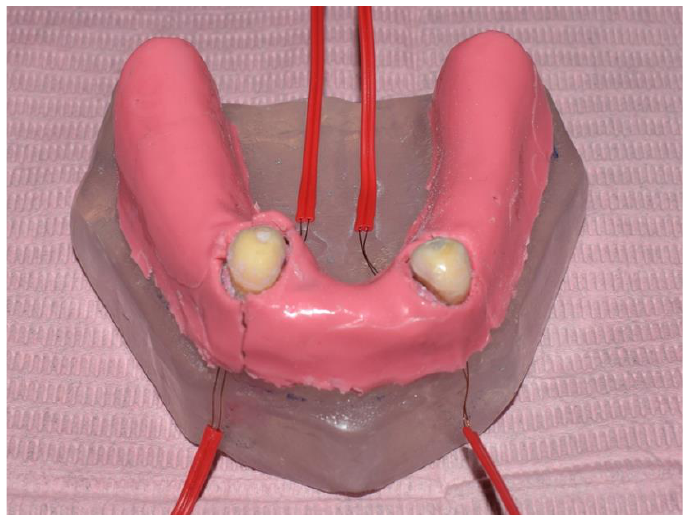
Figure 1a Strain gauge placed on the coronal one third of the abutments roots